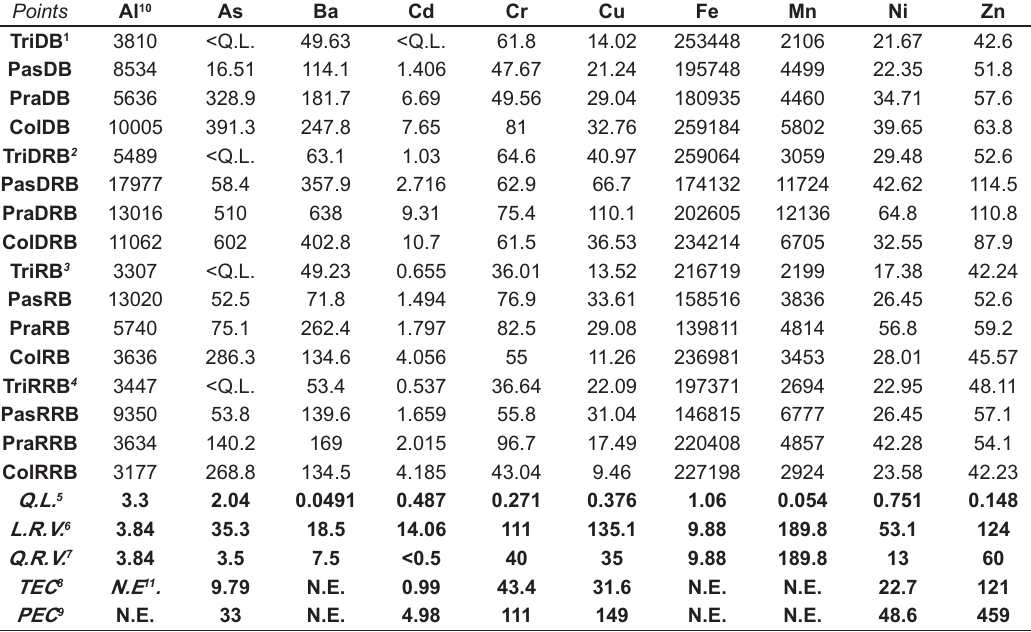
Table 1. Trace elements’ concentration in the studied area and their respective reference